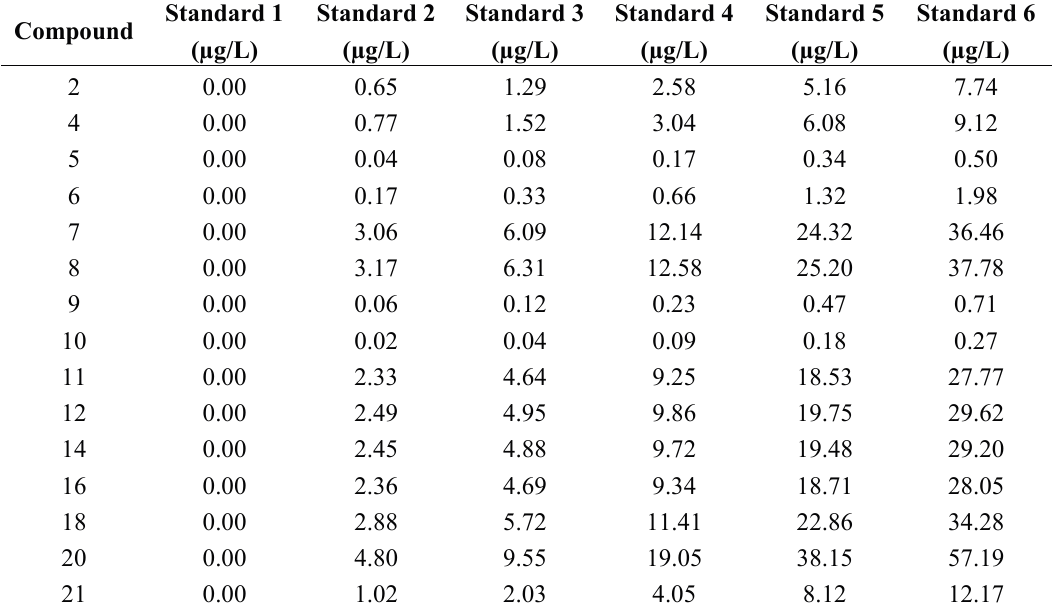
Table 6. Six point concentrations of each compound for